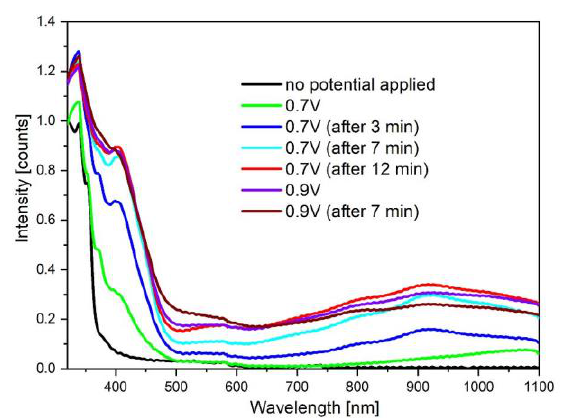
Figure 10. UV-Vis spectroelectrochemistry of the M2 derivative in chloroform solution (c = 1 × 10 −4 mol/L, as an inset on the graph potentials vs. Fc/Fc + redox couple).